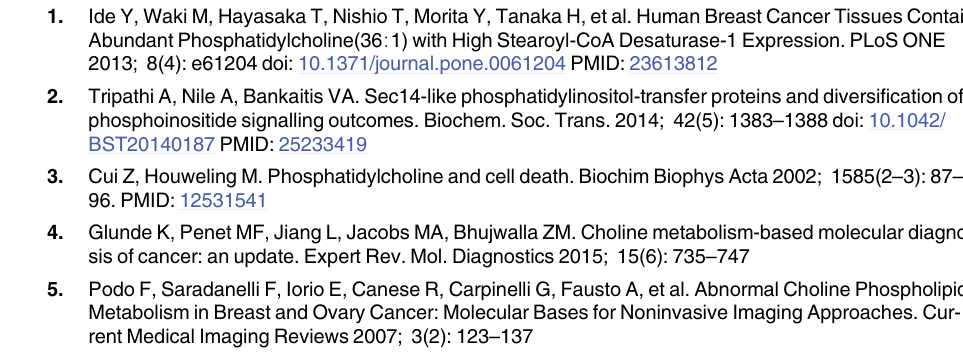
S1 Fig. Lipid uptake of [3H]choline expressed as relative to total protein (DPM/mg pro-